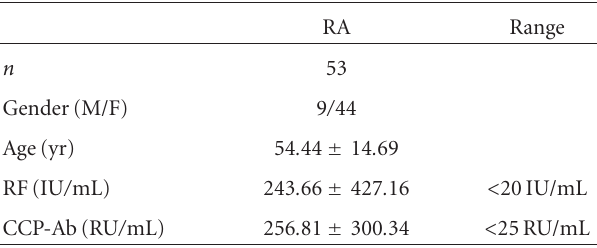
Table 1: Clinical features of RA patients included in the